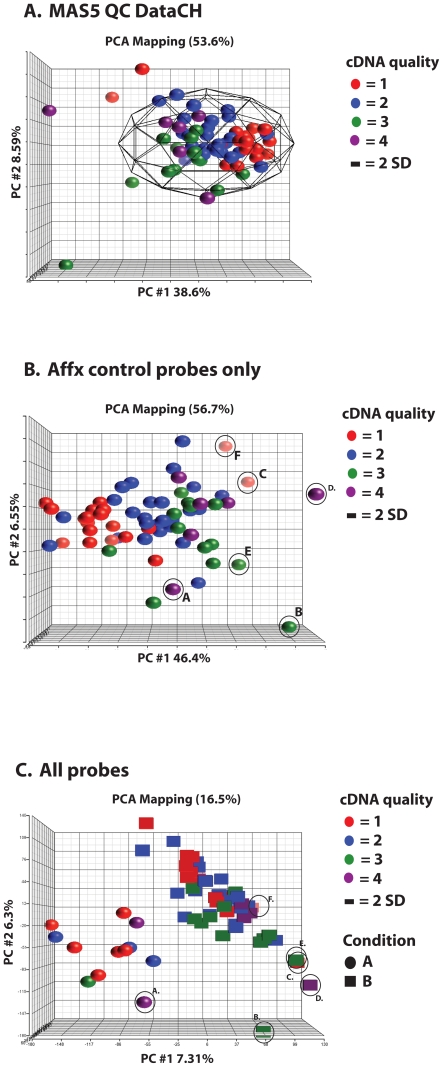
Assessing GeneChip quality control metrics and the effects of cDNA probe quality using Principle Components Analysis.(A) MAS5.0 QC data generated in Expression Console (Affymetrix) displayed using PCA illustrates the majority of GeneChips (n = 64) clustering together within 2 standard deviations of the group mean. The PCA is coloured according to the sscDNA quality score designated to each sample. Of the small number of samples lying out with the 2 SD boundary, sscDNA quality does not appear to be responsible for the variation shown, with this being contributed by other experimental factors. (B) PCA visualisation of Affx control probes only, coloured by sscDNA quality score shows that a significant proportion of the variation is driven by quality of the sscDNA probes. (C) PCA visualisation including all probes reveals the distinct sub-groups of the cohort according to expressed transcriptome patterns, regardless of cDNA quality.